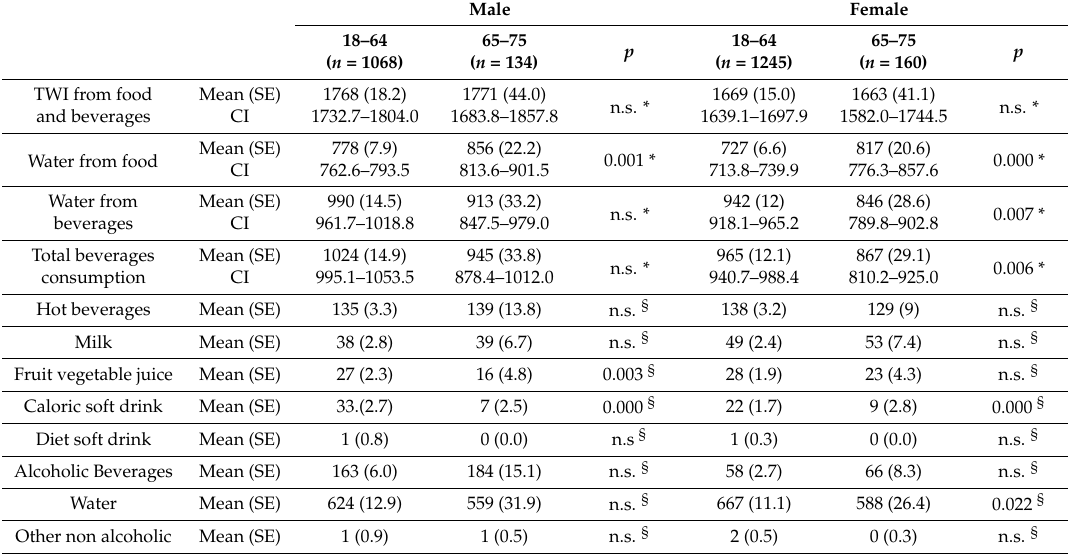
Table 2. Total water intake, water from food and beverages and beverage consumption (g/day), by gender and age group.